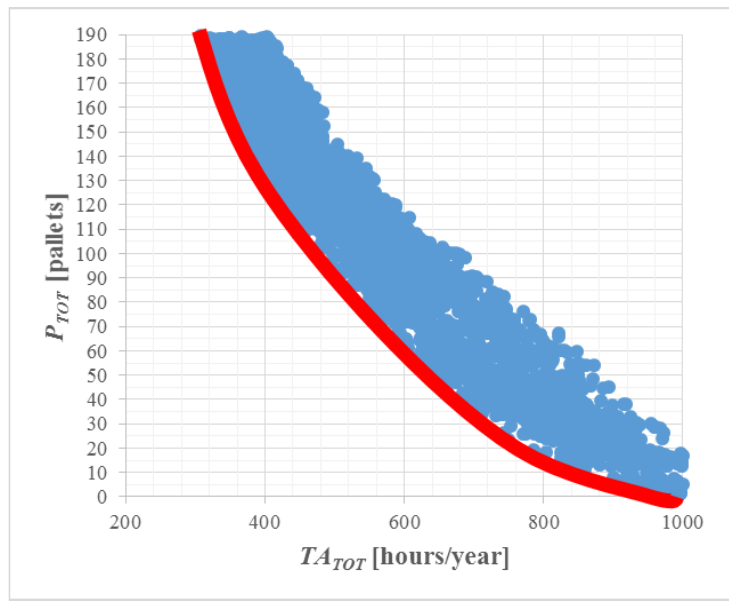
Figure 4. Objective functions plot for different Push/Pull scenarios.